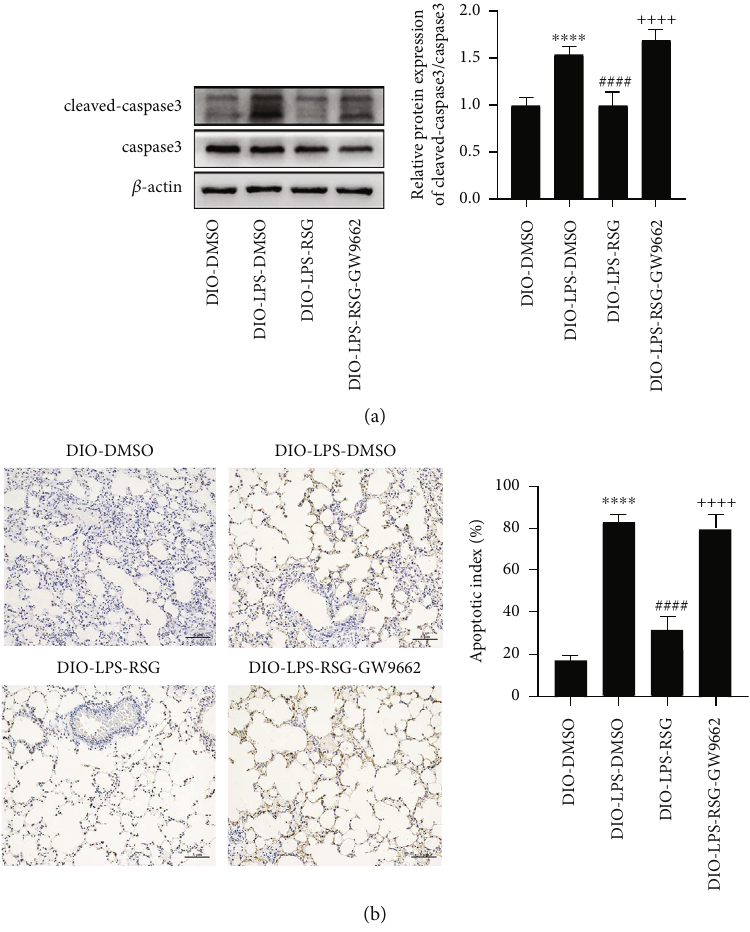
Figure 9: Activation of PPAR γ inhibited LPS-induced apoptosis in lung tissue of obese mice. (a) Western blotting and relative protein expression of cleaved-caspase3/caspase3 in lung tissue (cleaved-caspase3 was an activated form of caspase3). (b) TUNEL staining was used to detect apoptosis and apoptotic index of alveolar epithelial cells (original magni fi cation, × 200). Data are presented as mean ± SD . ∗∗∗∗ p < 0 : 0001 vs. DIO-DMSO; #### p < 0 : 0001 vs. DIO-LPS-DMSO; ++++ p < 0 : 0001 vs.